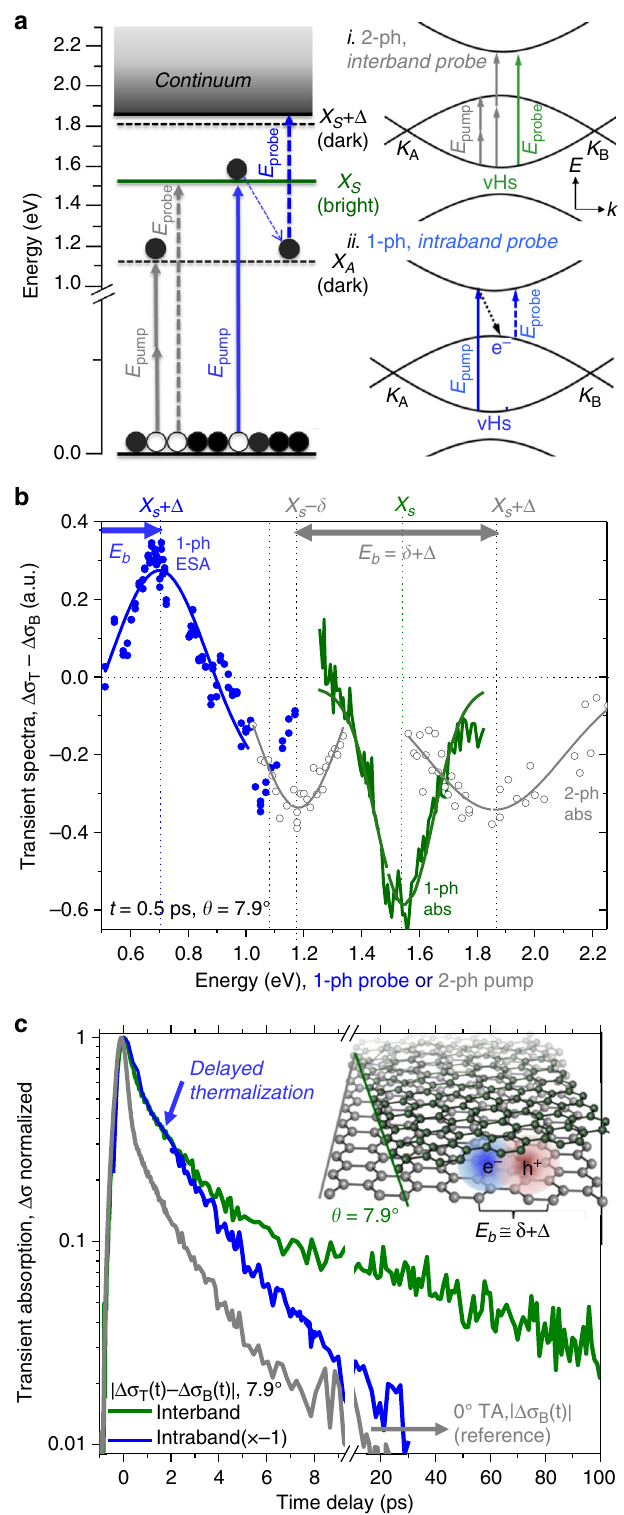
Fig. 4 TA spectrum estimates of exciton binding energy. a Two measures methods of E b , blue arrows: pump X S , with probe ESA to intraband exciton band-edge states near the e-h continuum. gray arrows: 2- photon pump, probe at X S . (right inset) Equivalent experiments in a vHs model. b Blue and gray TA spectra independently estimate E b at ~0.7 eV for θ = 7.9°. t BLG absorption spectra is in green. c Interlayer relaxation kintetics for both intraband and interband probe are delayed relative to the faster thermalization rate of 0° bilayer graphene shown in gray NATURE COMMUNICATIONS| (2019) 10:1445